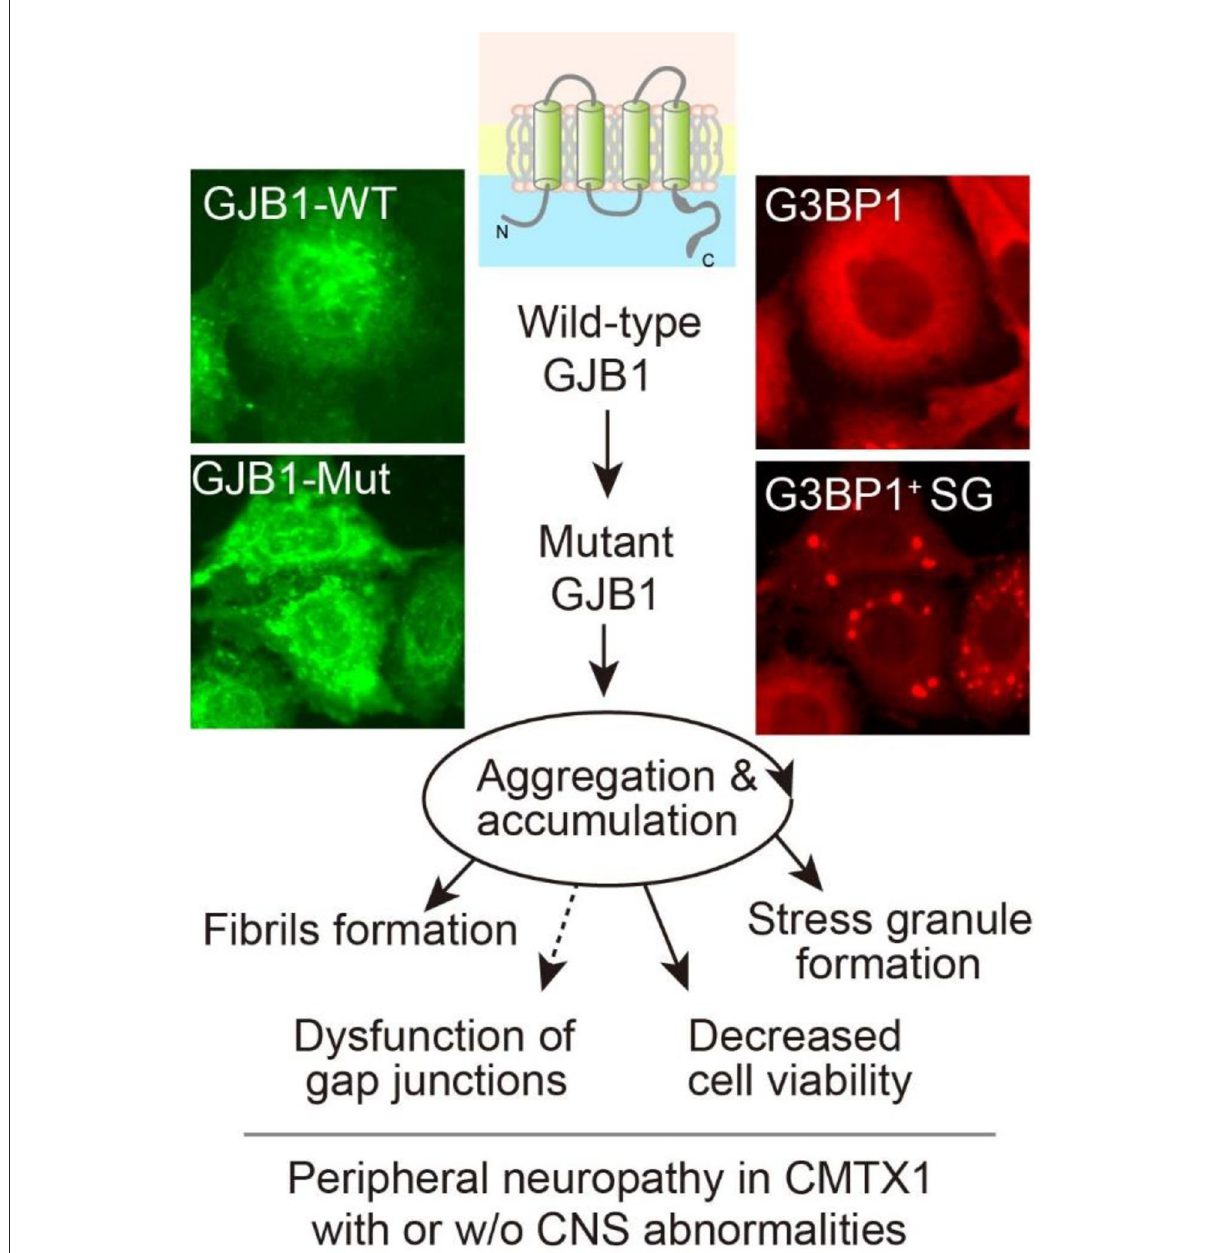
FIGURE8 Graphic working hypothesis of GJB1 mutation-induced CMT. As a gap junction protein, GJB1 normally spans the cell membrane to form gap junction channels. Ectopic WT GJB1 expression leads to its aggregation at a low extent, whereas mutations in GJB1 trigger a vicious circle via aggregation and accumulation of GJB1 species, which further causes intracellular stress granules formation and compromised viability. All the above evidence reflects CMT pathology in the peripheral system and possibly in CNS when mutation results in severe cell